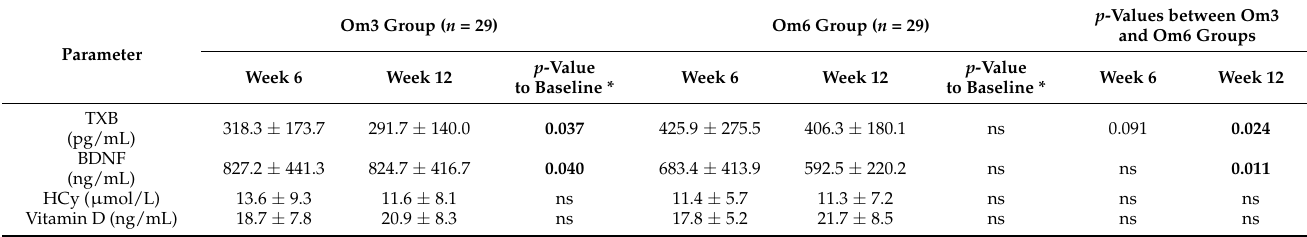
Table 3. The effect of omega-3 and omega-6 FA on TXB, BDNF, HCy, and vitamin D in patients with depressive disorder.